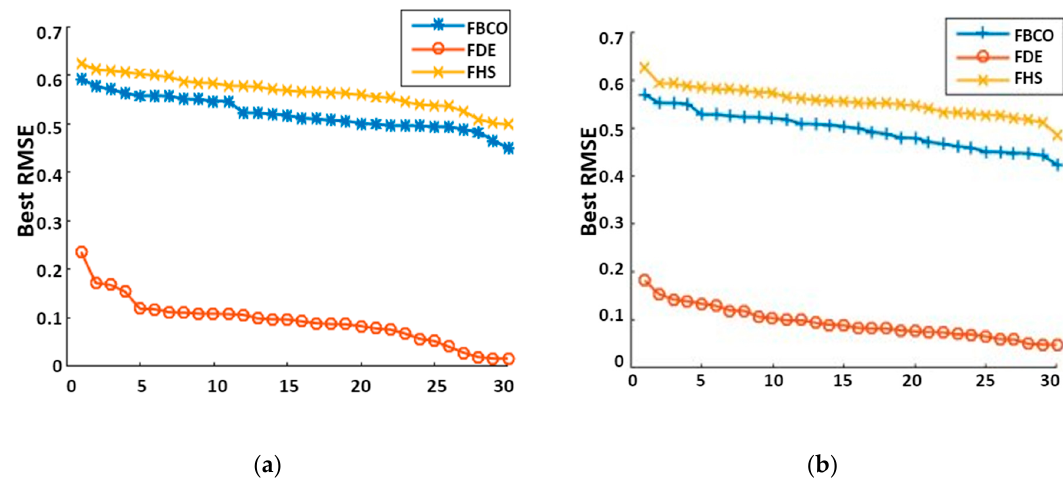
Figure 17. Comparison of the RMSE for each method for the water tank controller: ( a ) original algorithms, ( b ) fuzzy algorithm.